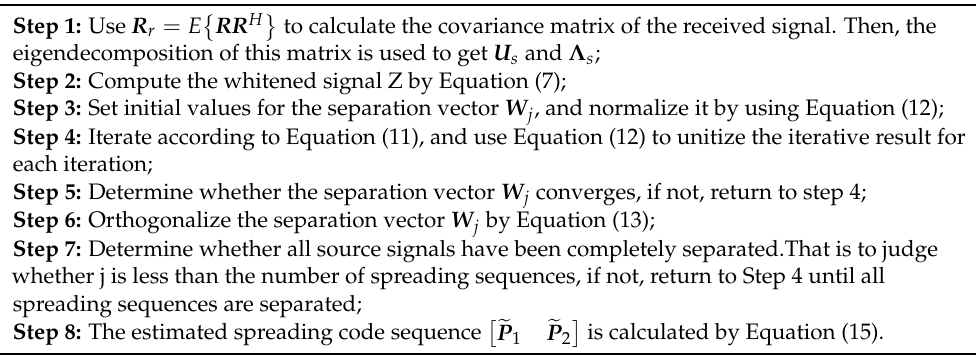
Table 1. The steps of the spreading code estimation method based on Fast-ICA.